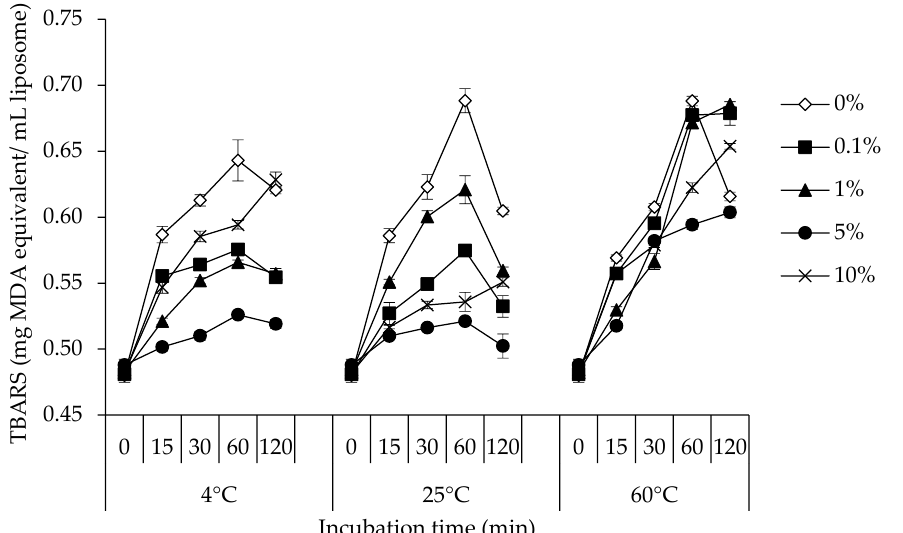
Figure 3. Changes in thiobaribituric acid reactive substances (TBARS) of lecithin liposome model system added with 0, 0.1, 1, 5, and 10% ( v / v ) of stingray non-protein nitrogen (NPN) incubated at 4, 25 and 60 °C for 0, 15, 30, 60, and 120 min. Bars indicate the standard deviation from triplicate determinations. MDA = malondialdehyde.